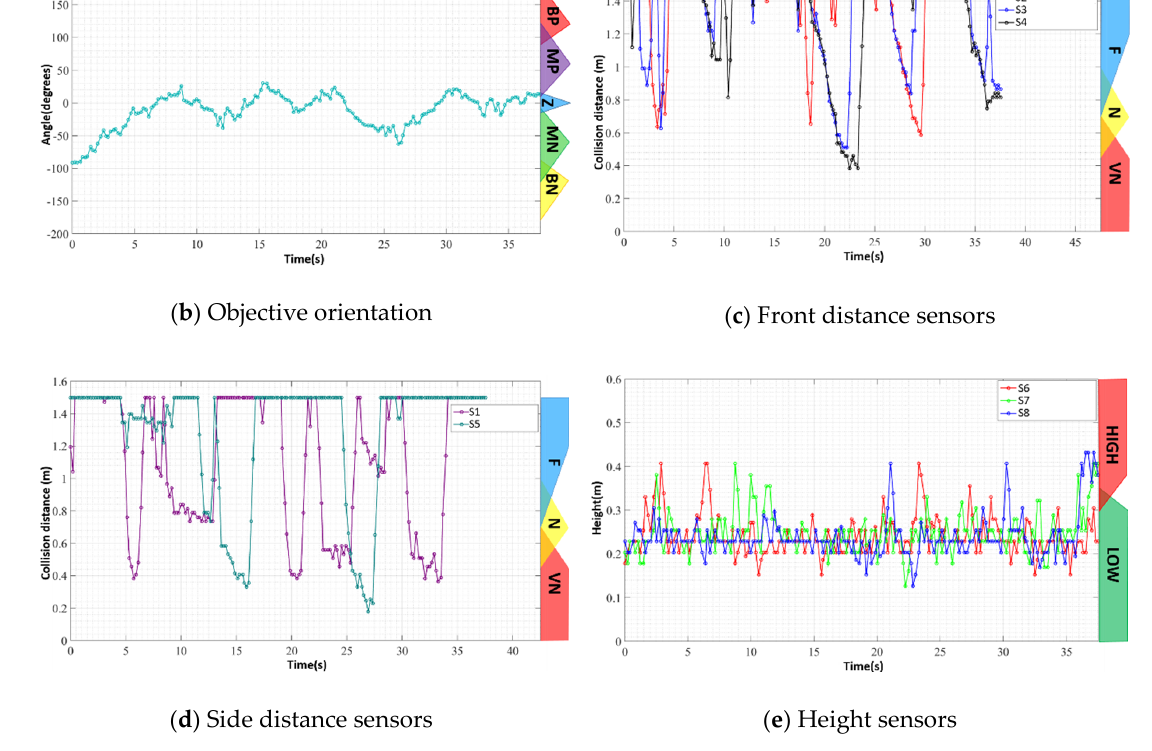
Figure 20. Sensor and actuator data during the route 2.